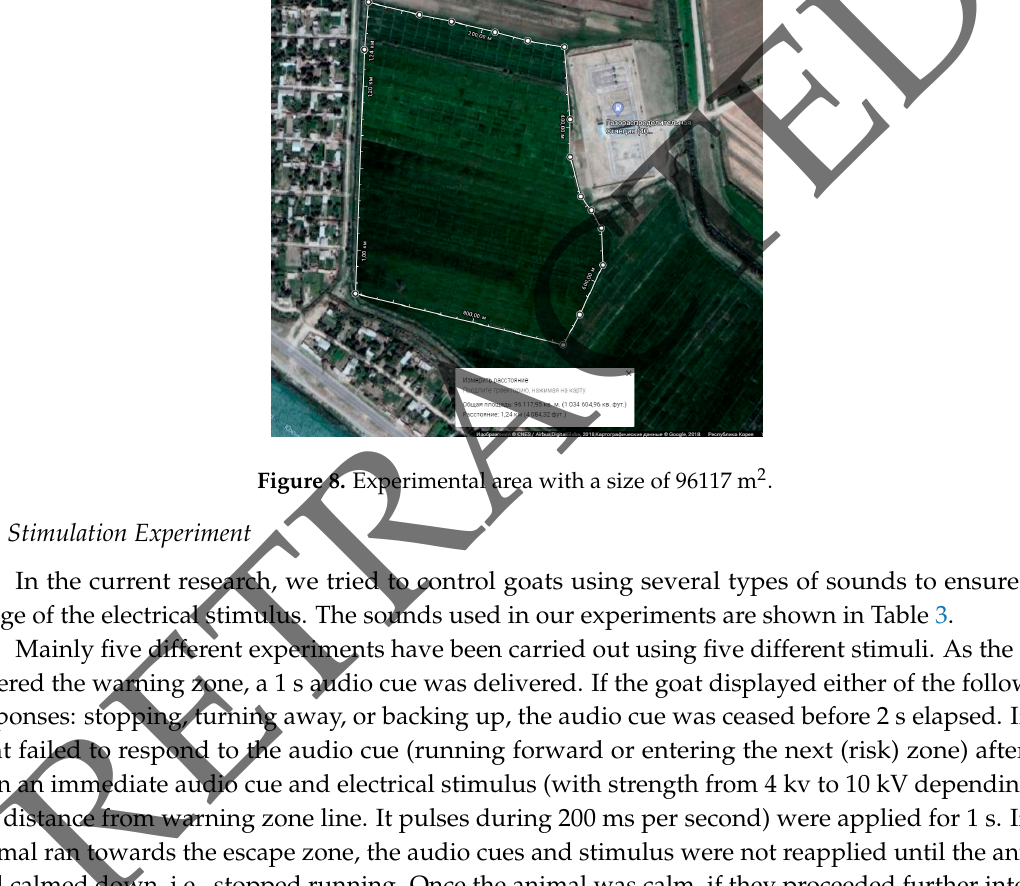
Table 4. Contingency table of the number of times the electrical stimulus was or was not applied to the goat, following an audio cue during the stimuli tests.